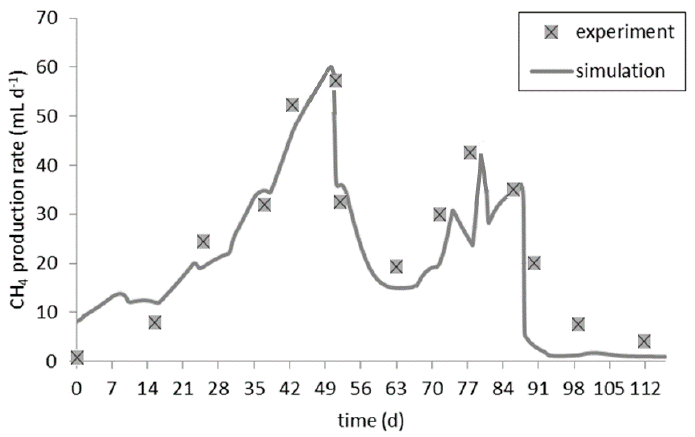
Figure 5. Simulated vs. observed current production by the cell.